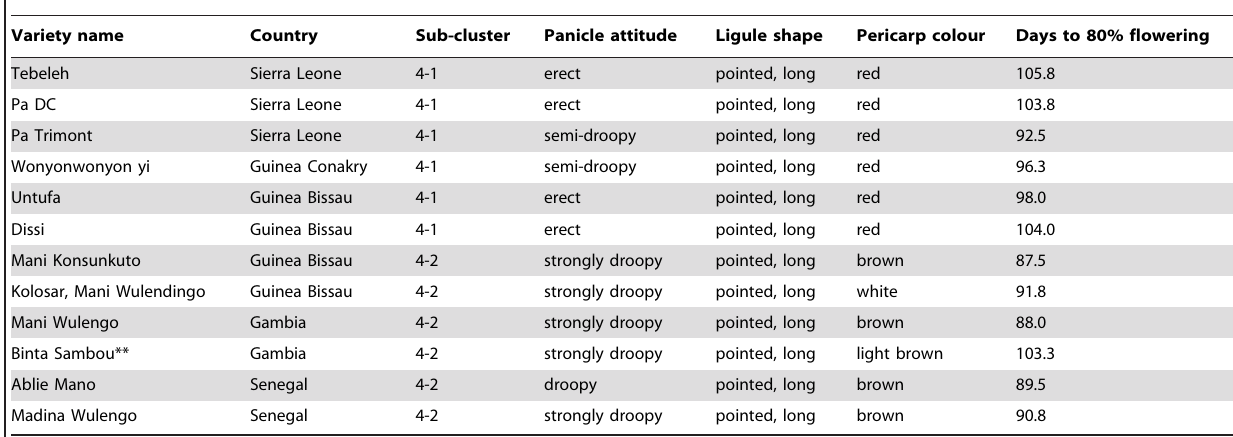
Table 3. Main distinctive morphological features of 12 varieties from cluster 4*.